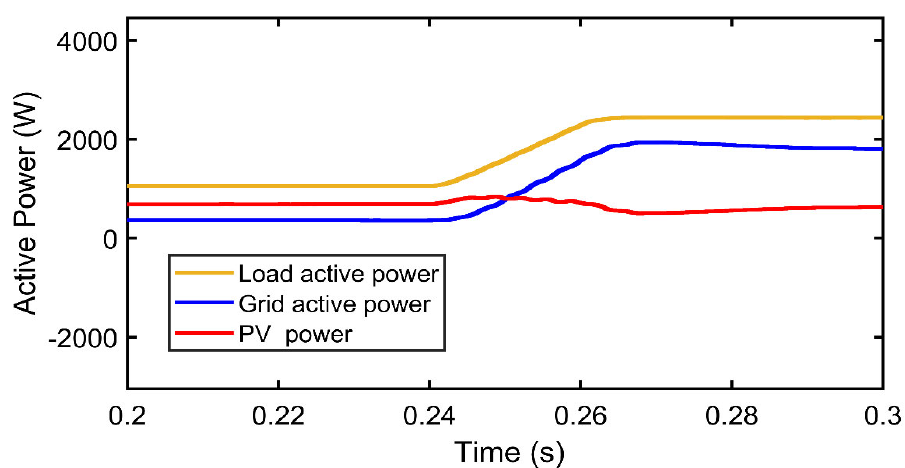
Figure 7. Real power management between grid load and PV under varying load demand.